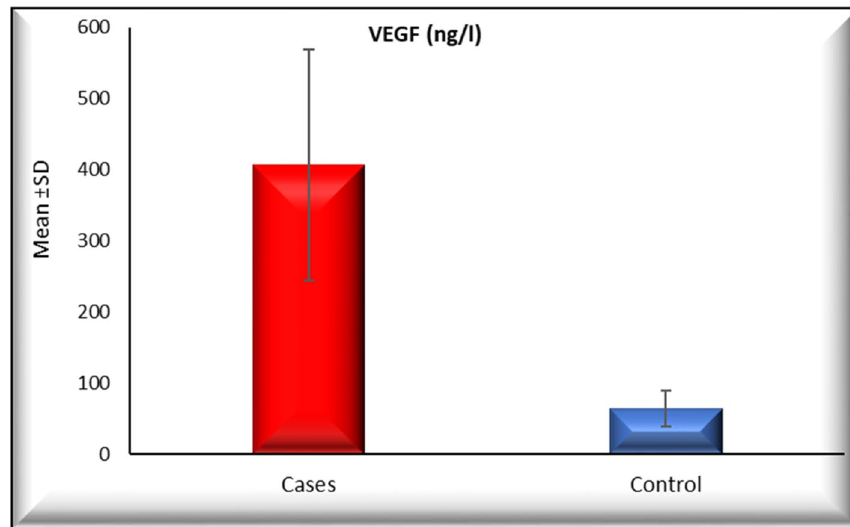
Fig. 1 Comparison of the VEGF levels between AS group and the control